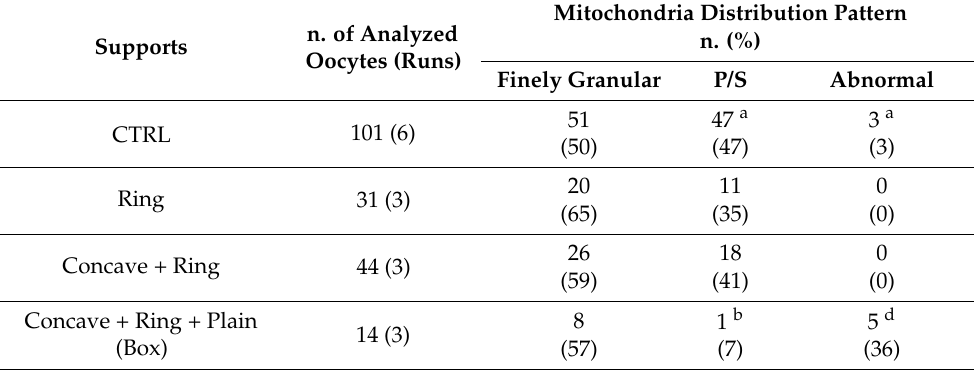
Figure 3. Representative photomicrographs of sheep COCs after culture under: ( A ) native mIVM; ( B ) by using the ring support and ( C ) in the presence of the biocompatible supports concave + ring. Both the mature oocytes obtained by mIVM culture in the presence of ring and Table 5. Effects of mIVM with biocompatible supports on mitochondria distribution pattern of sheep MII